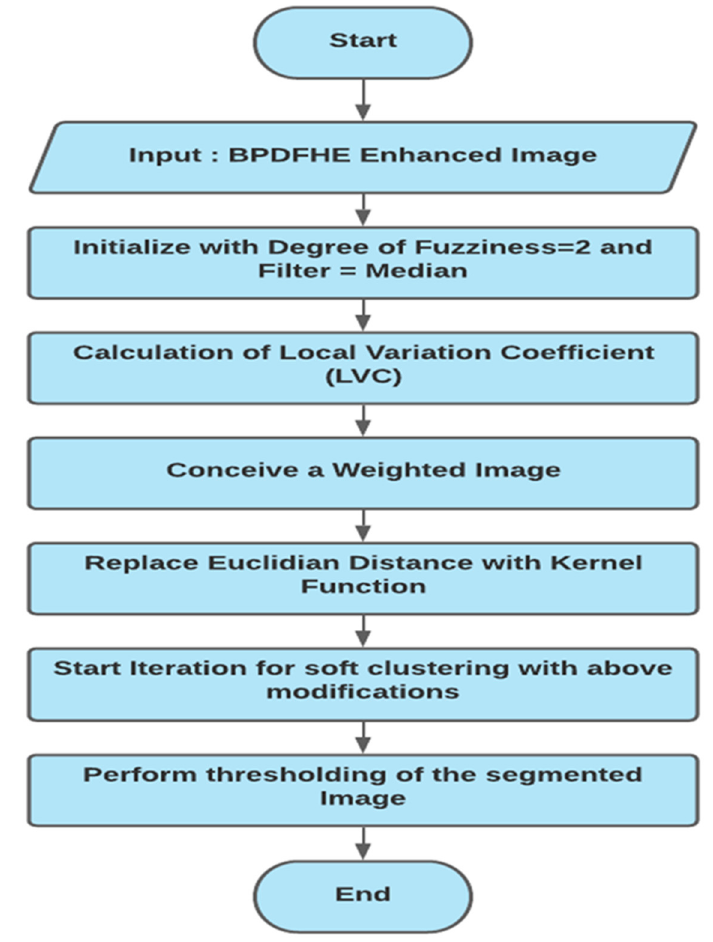
Figure 3. Flowchart of Segmentation (ARKFCM followed by thresholding) Process.